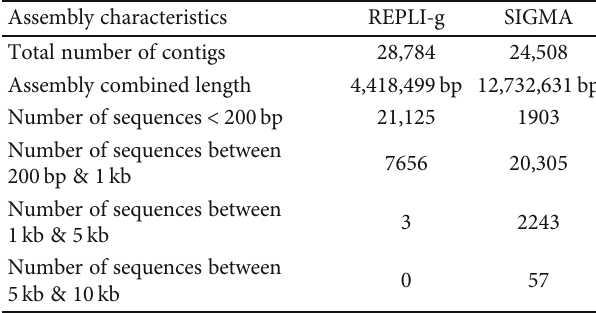
Table 1: Reniform nematode assembly characteristics for REPLI-g and SIGMA genomic libraries.